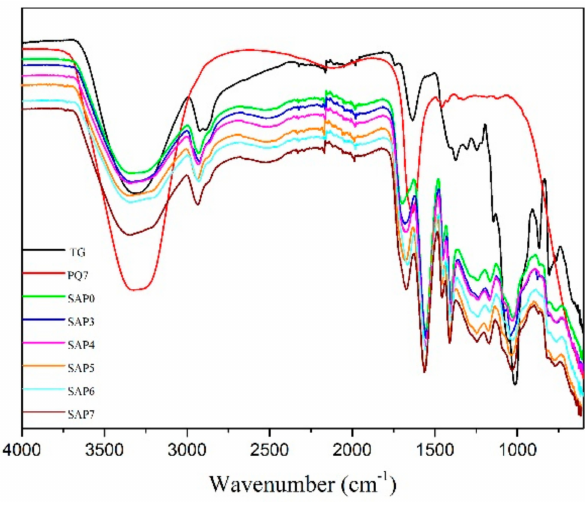
Figure 3. FTIR spectra of TG, PQ7 and all the samples.